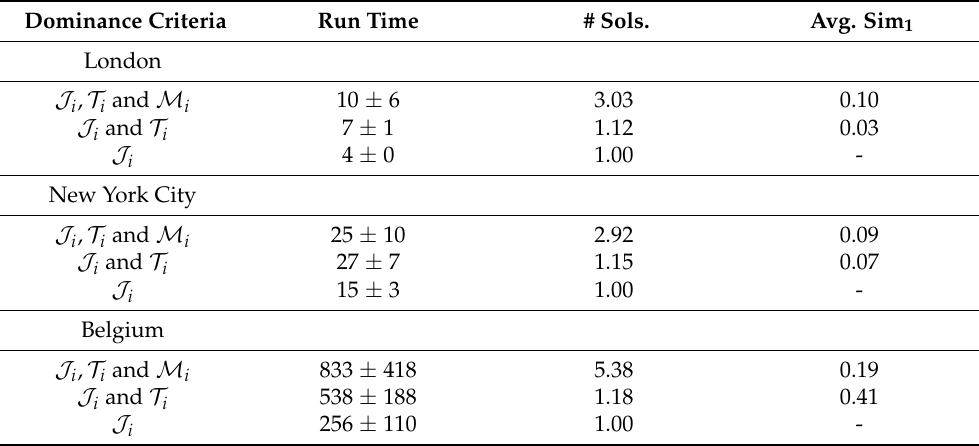
Table 4. Diversity